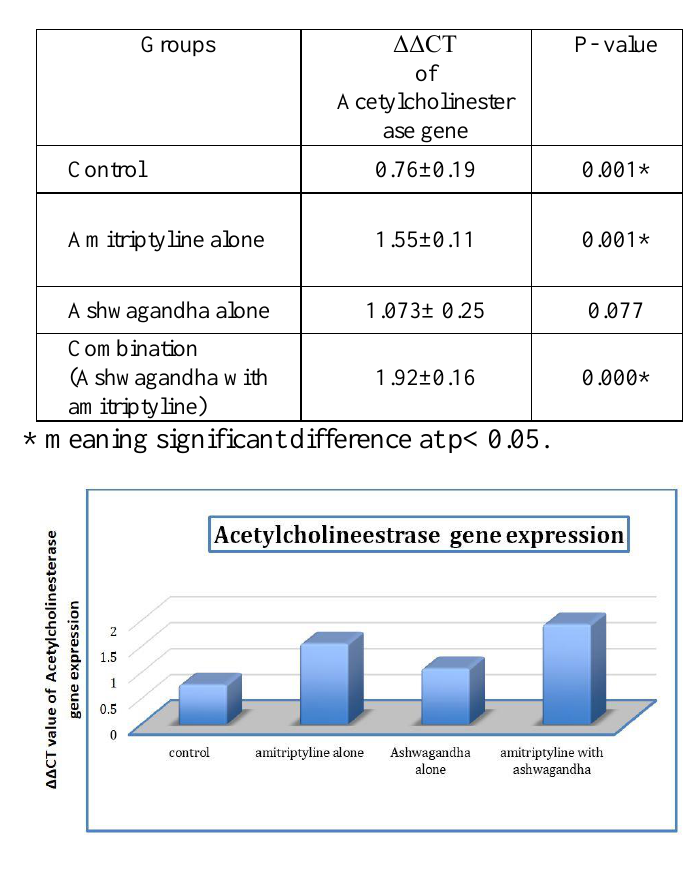
Fig.3: The histogram of the statistical analysis of the Acetylcholinesterase gene level after 30